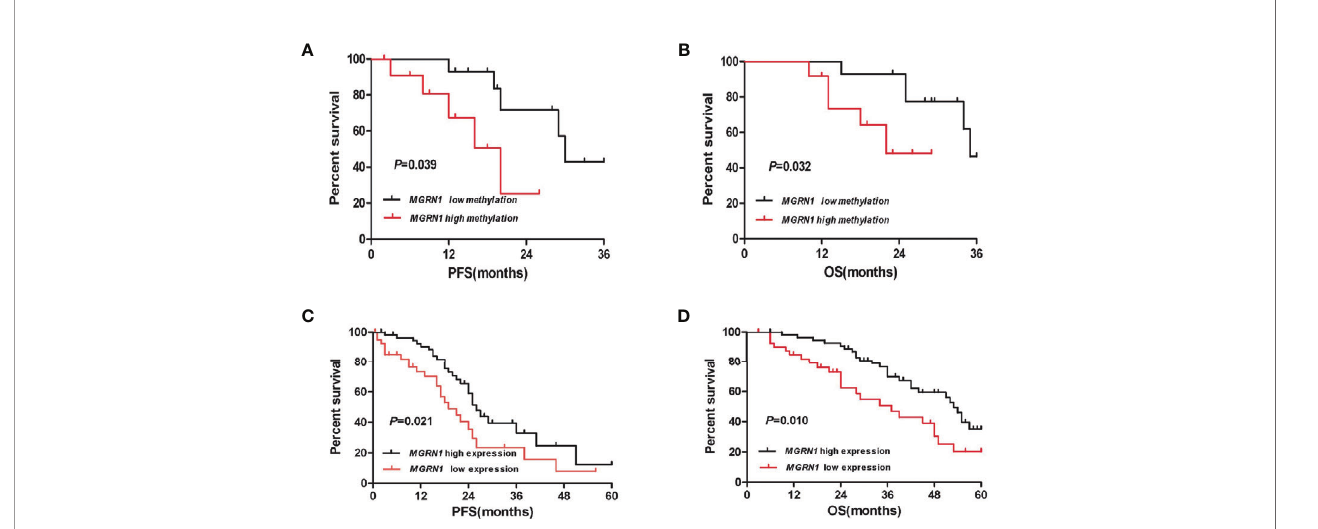
FIGURE 4 | The high methylation of MGRN1 and its low mRNA expression are associated with poor survival in HGSOC patients. (A, B) Kaplan-Meier analysis of PFS and OS according to the MGRN1 methylation level in 26 HGSOC patients. (C, D) Kaplan-Meier analysis of PFS and OS according to the MGRN1 mRNA expression in 96 HGSOC patients.